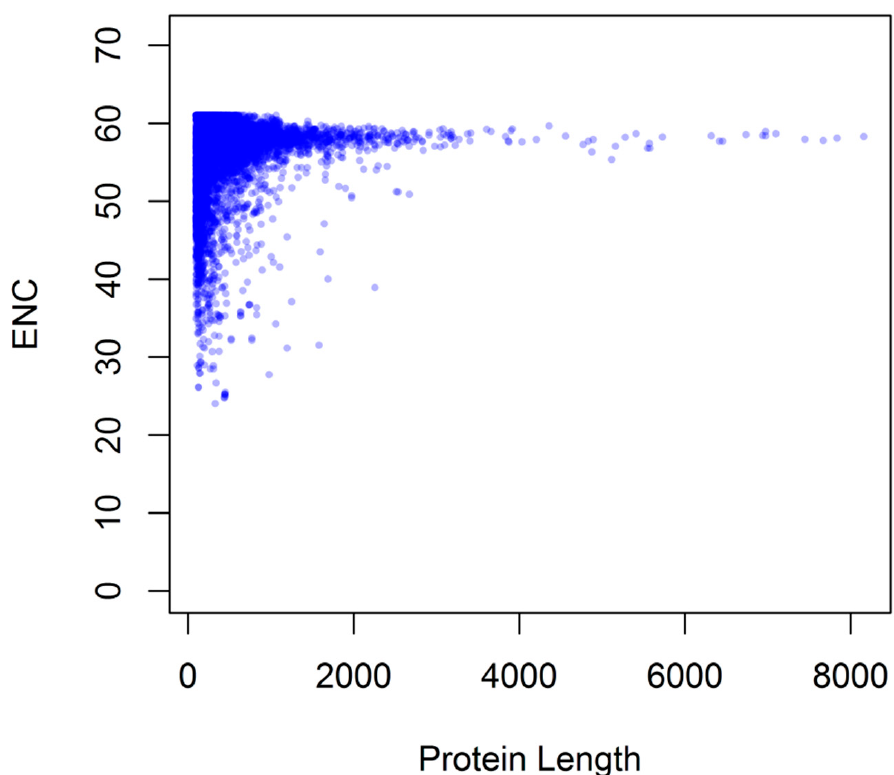
Figure 8. Relationship between ENC and encoded protein length for G. duodenalis .